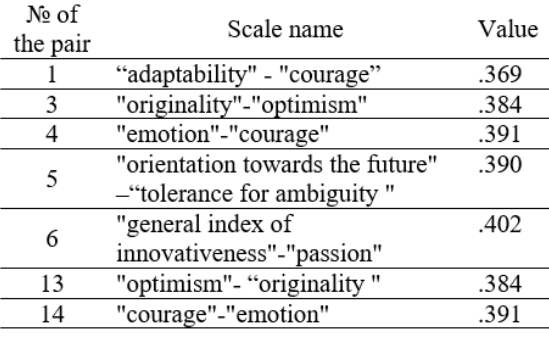
Table 1. The results of rank correlation analysis for all techniques in groups of adoles -